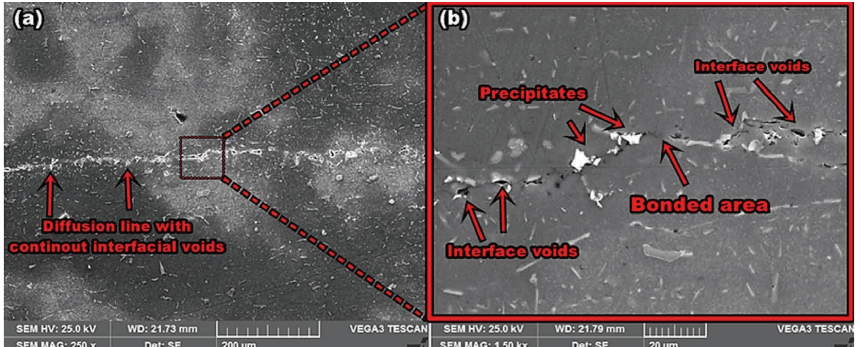
Figure 7: (a) SEM micrographs of the section bonded at 450 ° C and (b) detailed view of the rectangular drawn in (a).